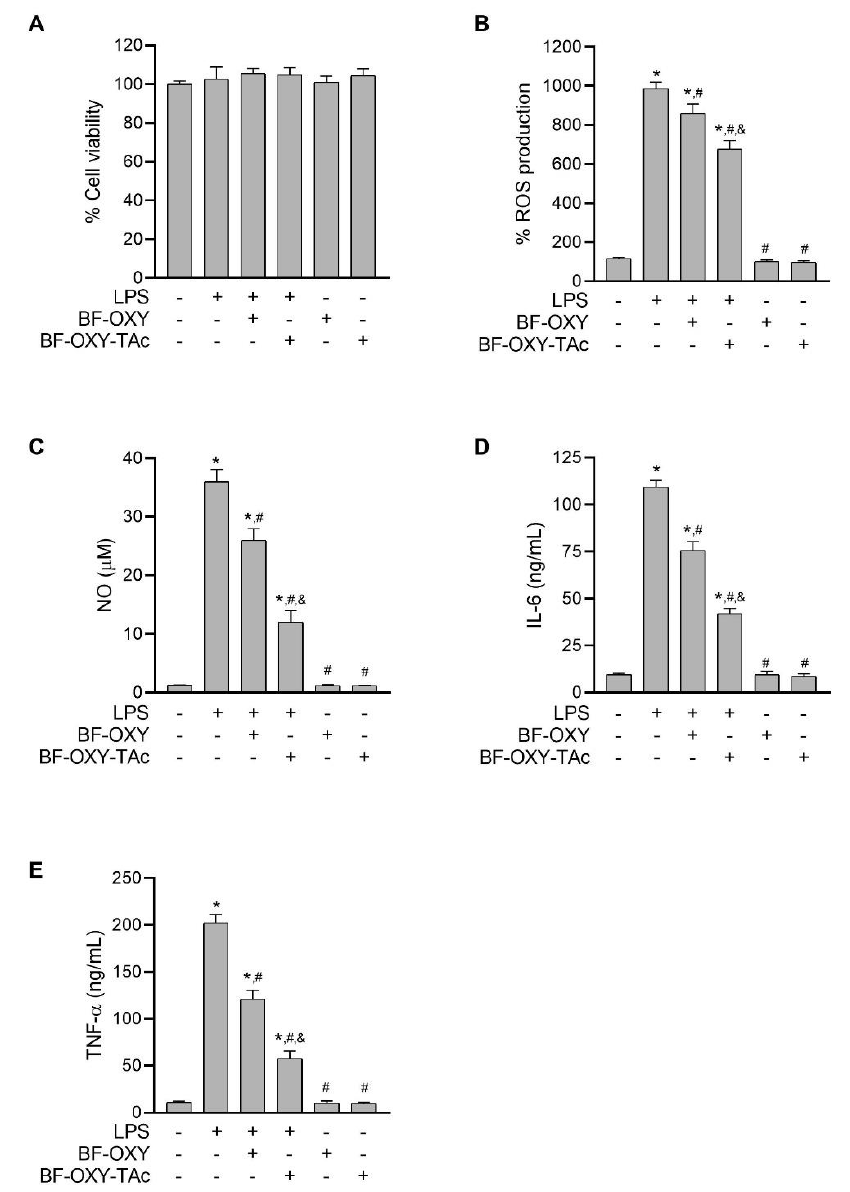
Figure 4. The effects of BF-OXY-TAc on cytotoxicity, ROS, NO, IL-6, and TNF- α production in LPS-stimulated RAW264.7 cells. The cells were pre-treated with BF-OXY or BF-OXY-TAc for 1 h before treatment with LPS (1 µ g/mL) for 24 h. ( A ) The cell viability was analyzed with the MTT method. ( B ) The evaluation of oxidative stress was conducted with a DCFH-DA-based assay. ( C ) The measurement of NO formation was performed using the Griess reaction. ( D , E ) The determination of IL-6 and TNF- α was performed by ELISA. The data are expressed as the mean of four replicates ± SD. * p < 0.05, vs. untreated control; # p < 0.05, vs. LPS; & p < 0.05, vs. LPS and BF-OXY treated group.